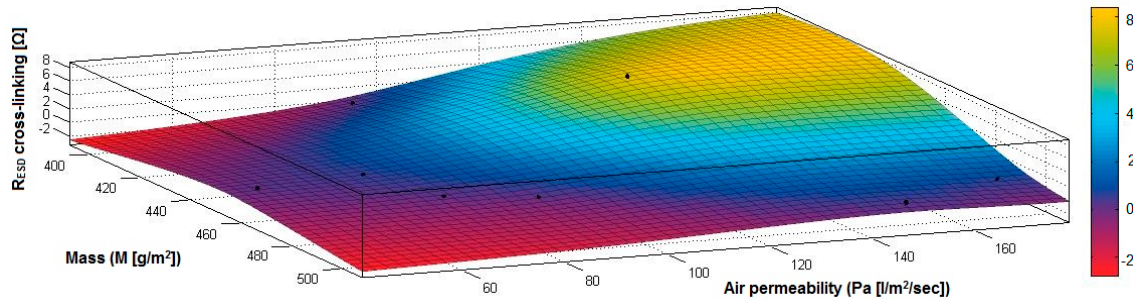
Figure 30. 3D representation R ESD after crosslinking = f(M, Pv) samples preliminarily treated in RF plasma O 2 using RF 1 generator and power 200 W.